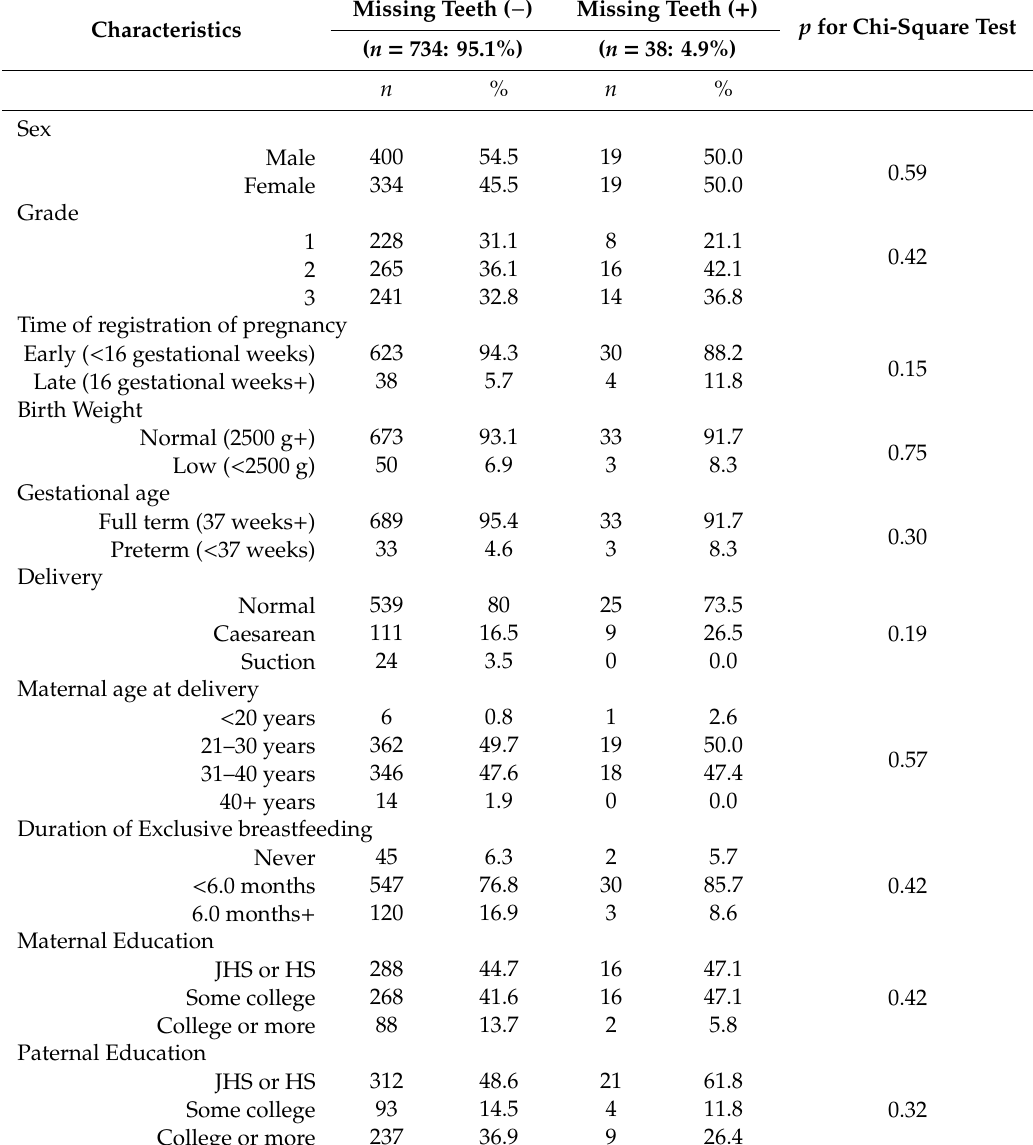
p for Chi-Square Test